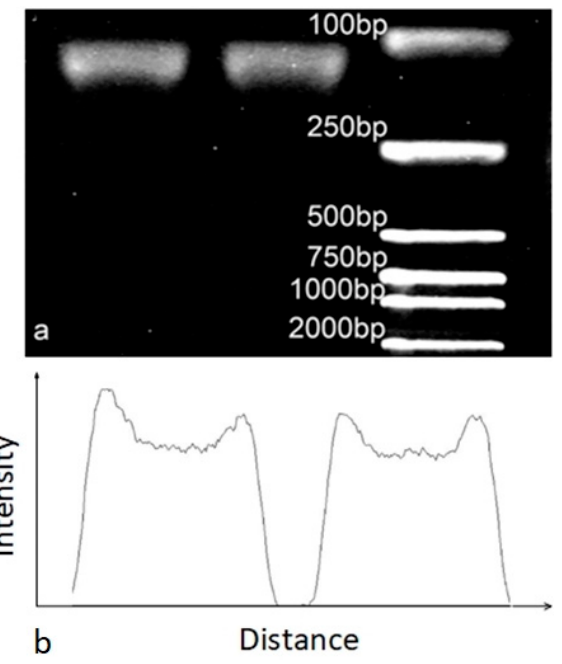
Figure 7. Electrophorogram and intensity diagram of the liquid droplets’ PCR experiment. ( a ) Electrophoretic results by commercial cycler ( left ), electrophoretic results by microdevice ( middle ) and the ladder ( right ). ( b ) The intensity diagram of commercial cycler PCR electrophoretic results ( left ) and microdevice PCR electrophoretic results ( right ).